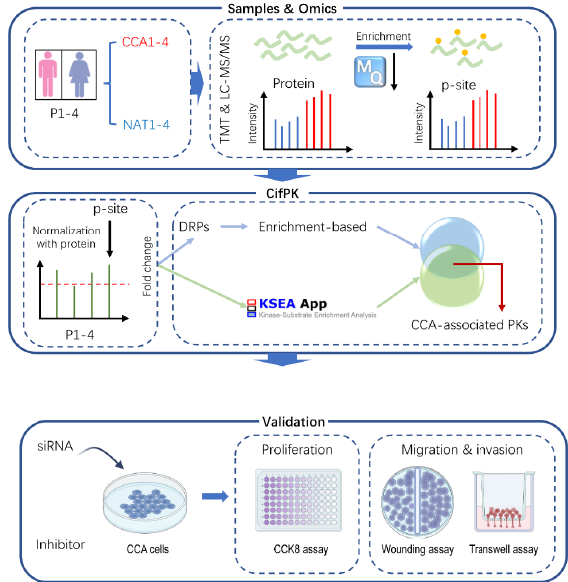
Figure 1. The workflow of this study. First, TMT-labeled and LC-MS/MS-based proteomics and phosphoproteomics of CCA tumors with corresponding NAT samples were profiled. Then, after the normalization of quantified p-sites with corresponding proteins, an integrated pipeline CifPK was developed to predict the CCA-associated PKs. Last, the experimental assays were performed to validate the effect of potential CCA-associated PKs by using siRNAs and selective inhibitors of PKs.